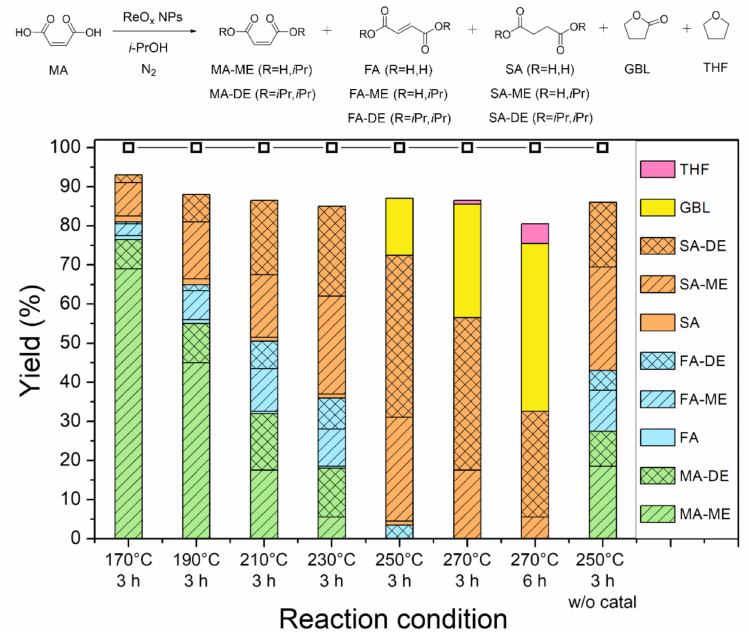
Figure 4. Conversion of maleic acid (MA) over ReO x NPs in isopropanol: Reaction conditions: batch reaction, ReO x NPs (10 mg, 4 mol% Re relative to substrate), MA (1 mmol), i -PrOH (10 mL), and N 2 (15 bar). Conversion and yield are calculated by 1 H NMR and